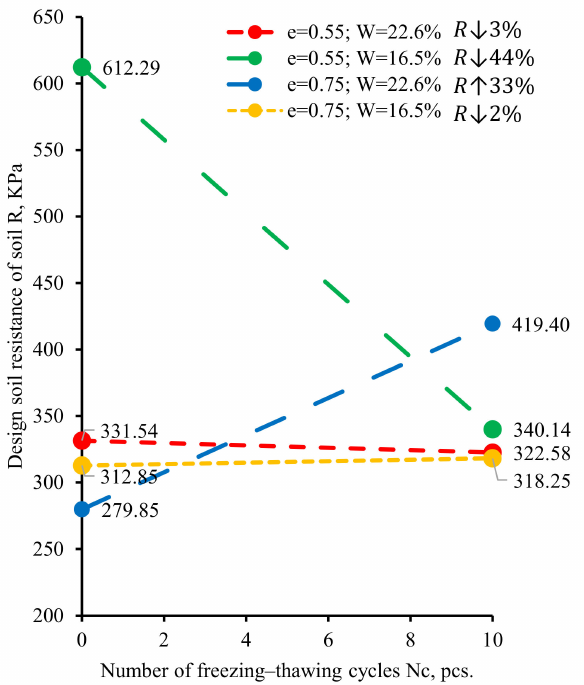
Figure 9. Dependence of design soil resistence from the number of freezing-thawing